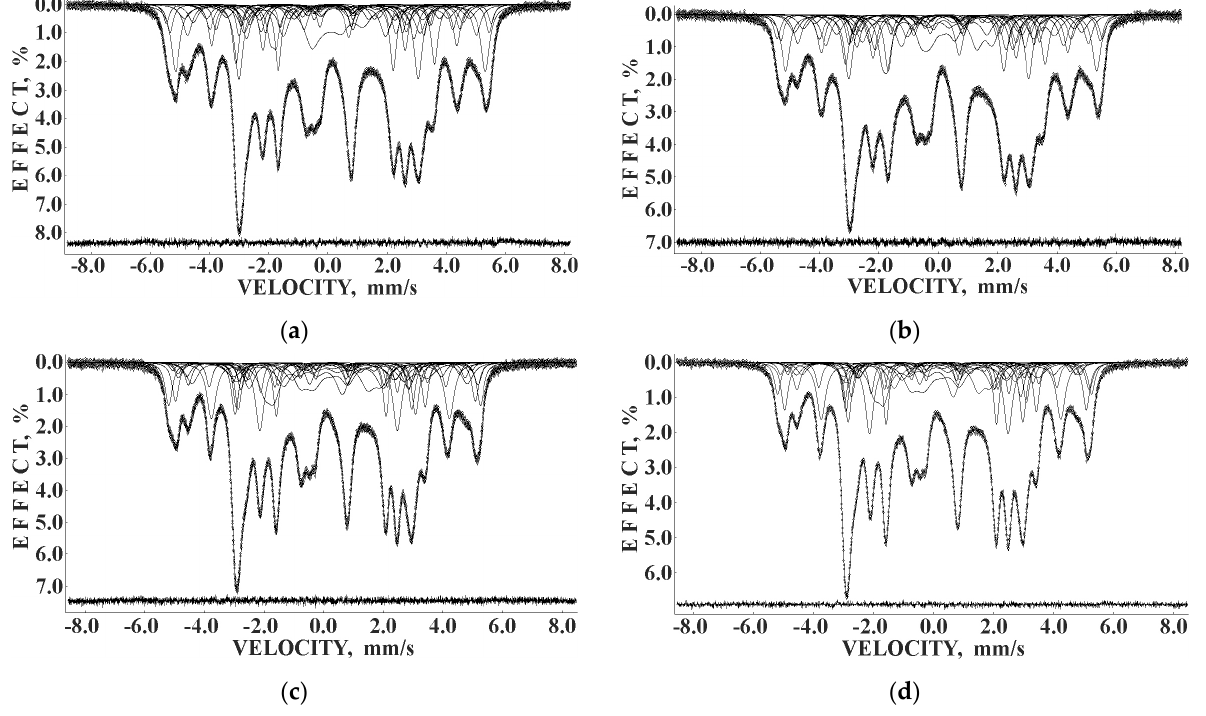
Figure 79. Room temperature Mössbauer spectra of FINEMET ribbons with different permeabilities: FT1, μ r = 1350 ( a ), F2, μ r = 6000 ( b ), F1, μ r = 34,500 ( c ) and F2, μ r = 190,000 ( d ). The Mössbauer spectra were measured in 4096 channels while the spectrum of F2 was converted into 2048‑channel spectrum. These spectra were fitted using 18 magnetic sextets with the same ratio A 2,5 / A 1,6 . The differential spectra are shown on the bottom.